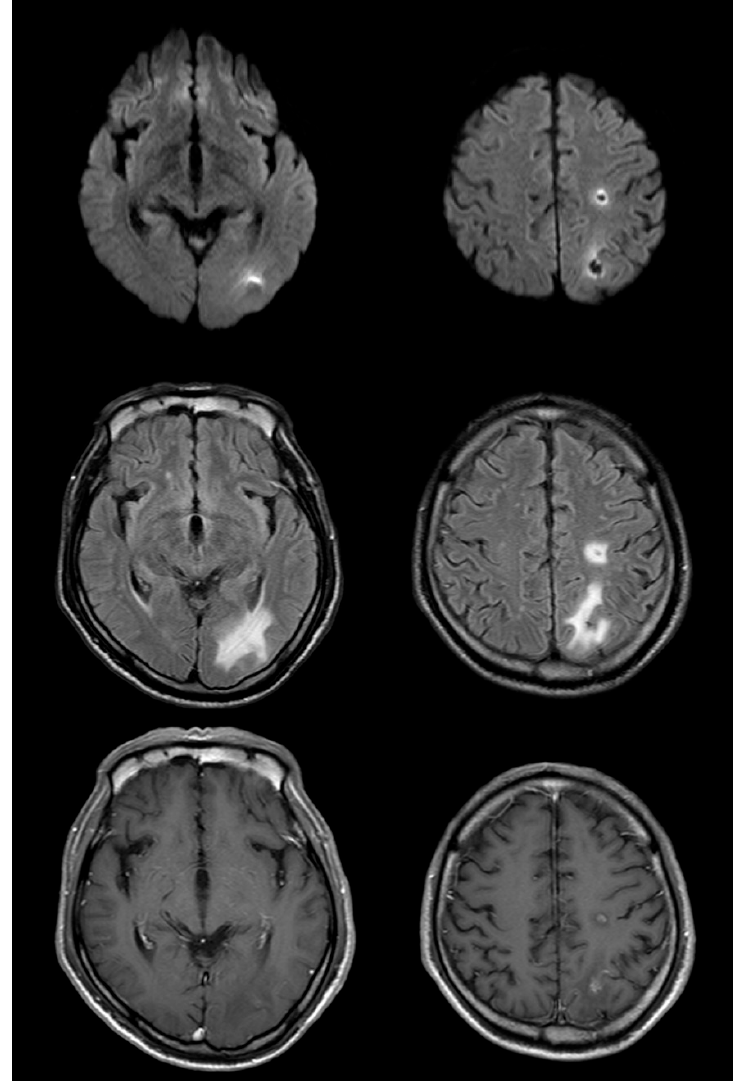
Figure 3. Magnetic resonance imaging (MRI) on the 52nd day after symptom onset reveals a decrease in the size of lesions compared with that in the prior study (top row: diffusion-weighted imaging (DWI); middle row: fluid-attenuated inversion recovery (FLAIR); bottom row: post-gadolinium). Edema and enhancement are markedly decreased compared to that in the previous MRI; changes originally seen on DWI are evolving and resolving as well.